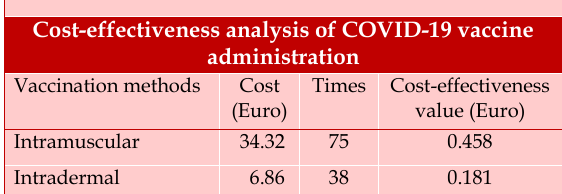
Cost-effectiveness analysis of COVID-19